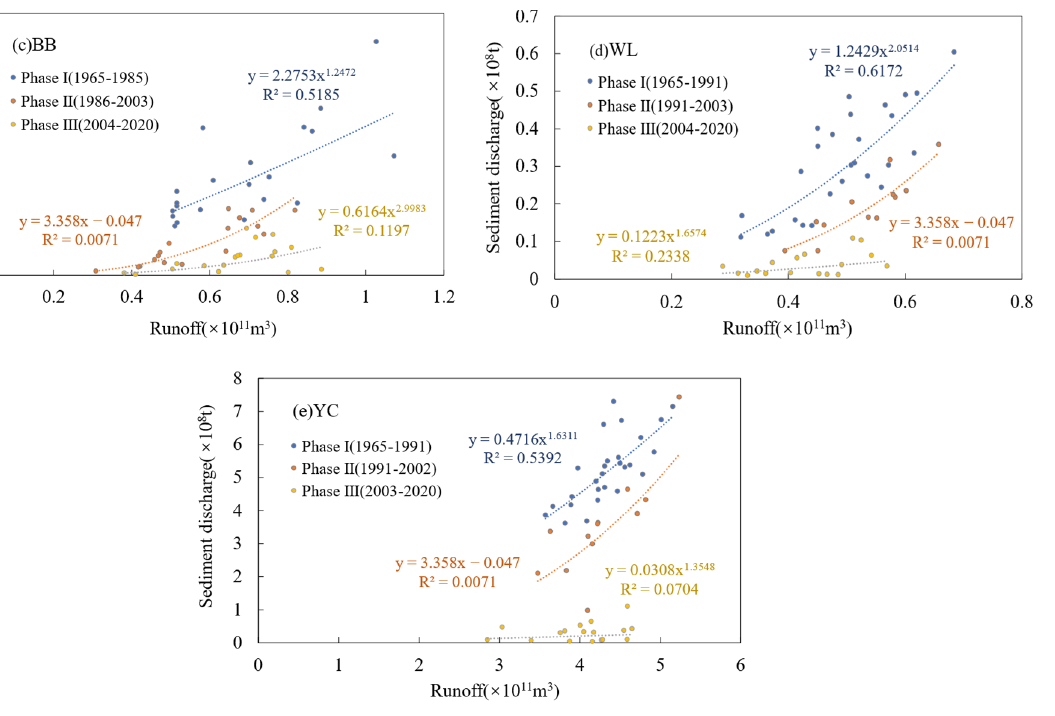
Figure 7. Relationship between annual runoff and sediment load in the upper reaches of the Yangtze River.